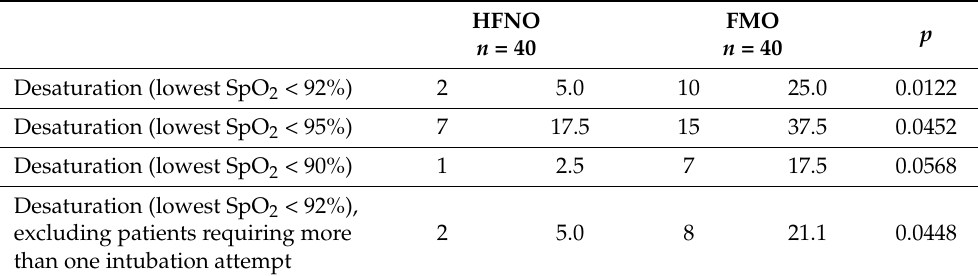
Table 4. Sensitivity analyses for peri-intubation oxygen desaturation.